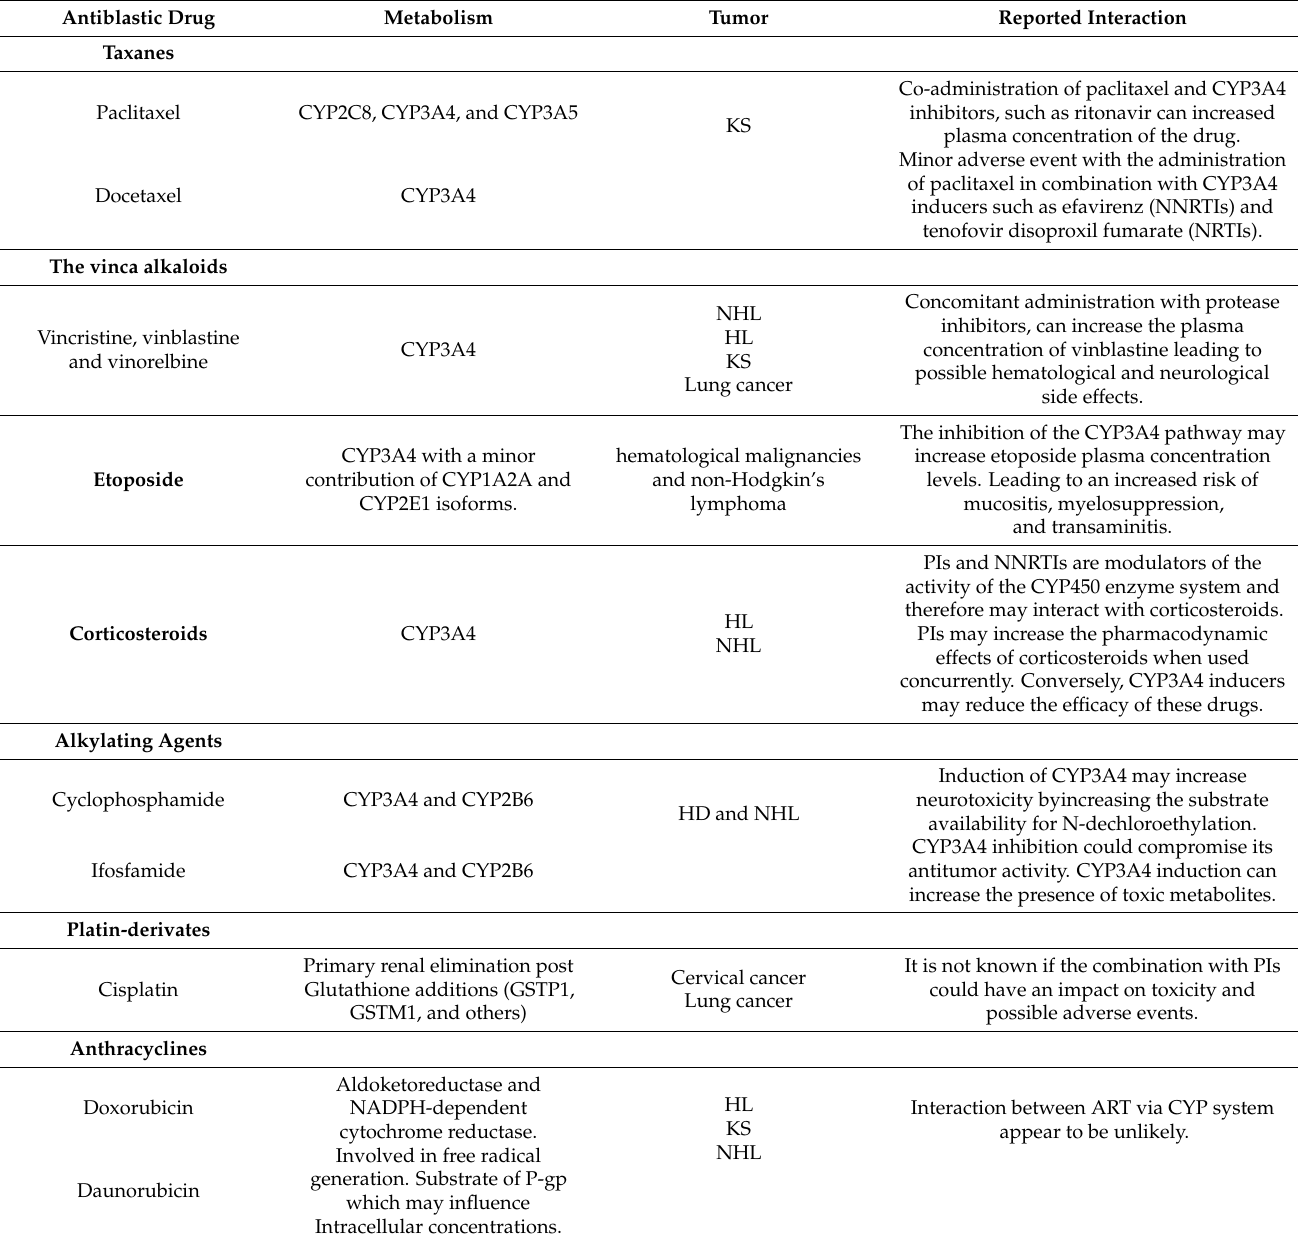
Table 1. Drug-drug interaction between ART and chemotherapeutic